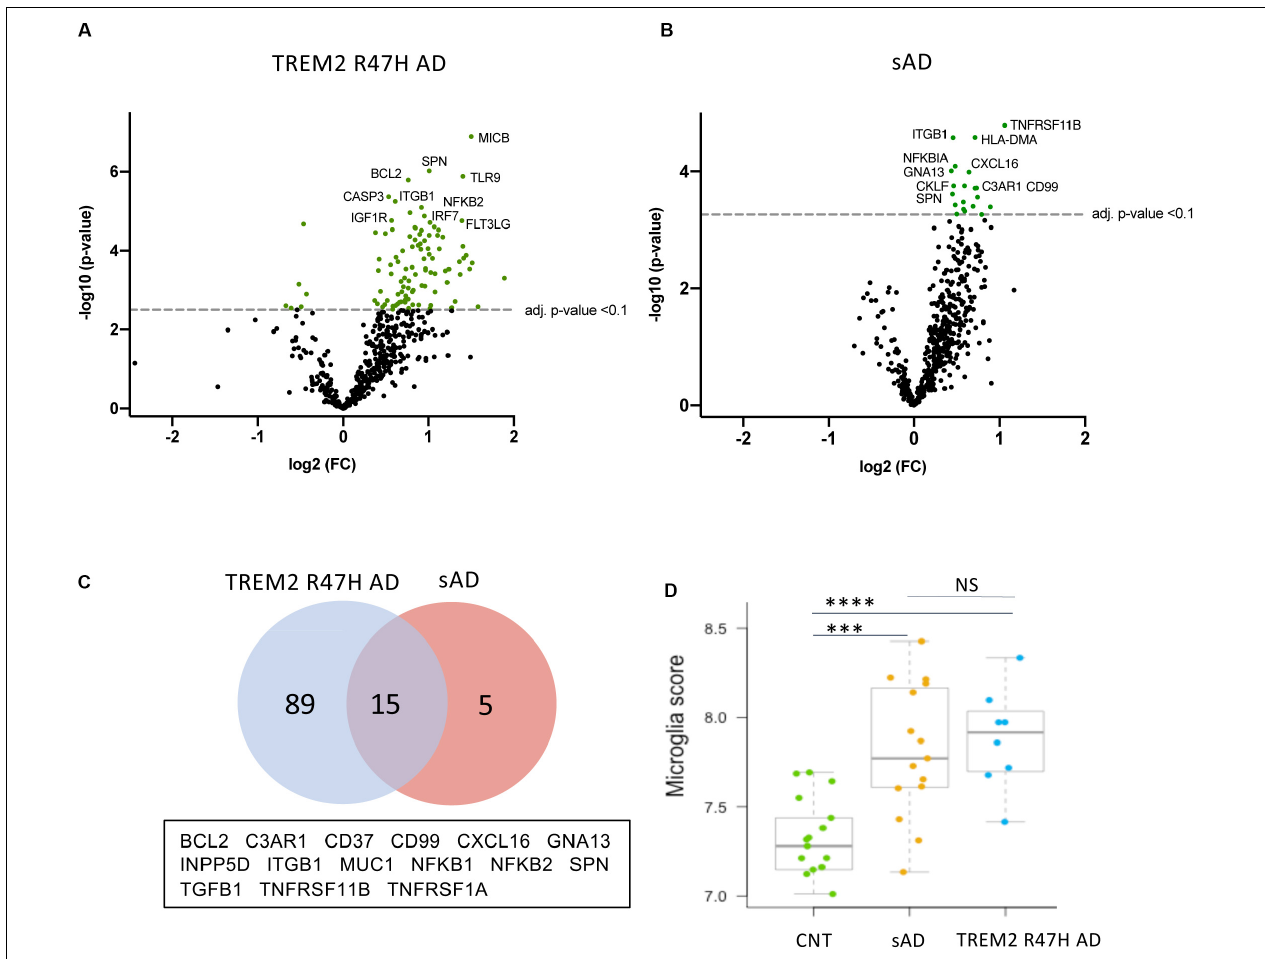
FIGURE 1 | Differentially expressed (DE) genes in hippocampi of TREM2 R47H AD and sAD patients. (A–D) Volcano plots displaying DE genes in TREM2 R47H AD (A) and sAD (B) against a baseline of gene expression in controls. y -Axis corresponds to the log 10 ( p -value), and the x -axis displays the log 2 (FC, fold changes) value. (C) Venn diagram and list of shared DE genes (FDR < 0.1) between TREM2 R47H AD and sAD. (D) Microglia cell scores were calculated by nSolver (v.3) as an average log-transformed expression of 134 microglia-specific genes that allow comparison of cell abundance across samples (71). Each unit increase in a cell score calculated from log2 transformed data corresponds to a doubling of microglia abundance (NS, non-significant; ∗∗∗ p -value < 0.001, ∗∗∗∗ p -value < 0.0001, one-way ANOVA, and Tukey’s multiple comparison test).